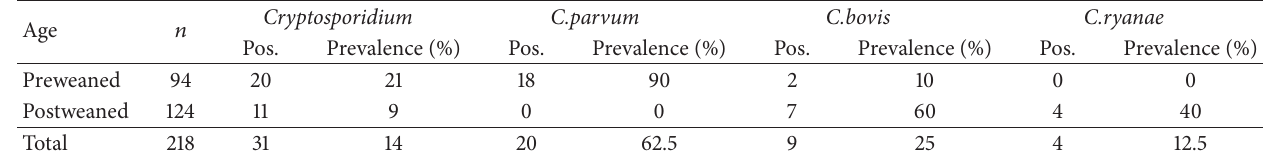
Table 1: Prevalence of Cryptosporidium species in